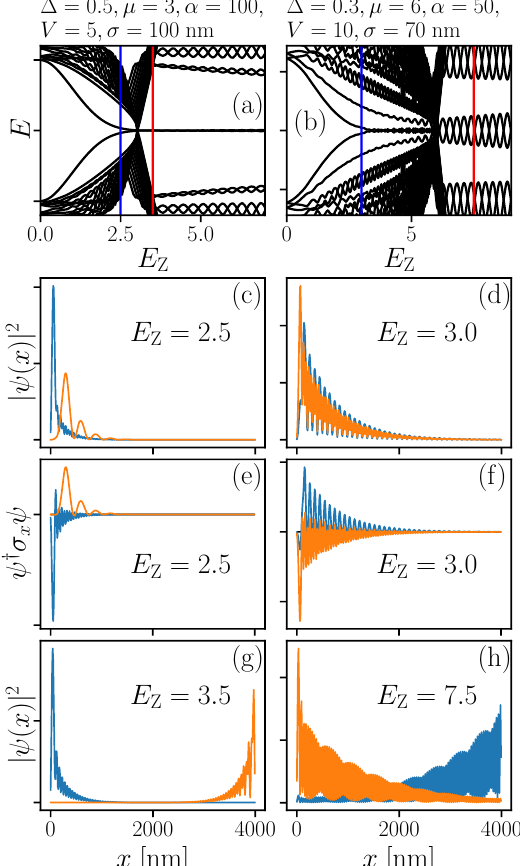
Figure 4: Wave functions and spin densities in the device sketched in Fig. 2(a) with a smooth potential on the left edge. The left column shows results for parameters such that the Majorana components in the trivial regime are partially separated, the right column for fully overlapping components. (a, b): Energy spectrum as a function of E . The blue and the red vertical lines indicate the Zeeman energies at which Z respectively the trivial and topological wave functions of the lower panels are